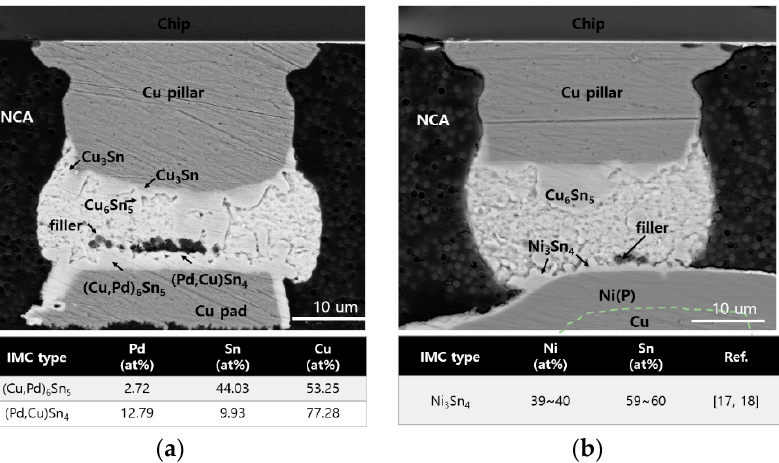
Figure 10. Cross-sectional SEM micrographs and EDS of Cu/SnAg pillar bumps on ( a ) EPIG and ( b ) ENEPIG surface finishes.